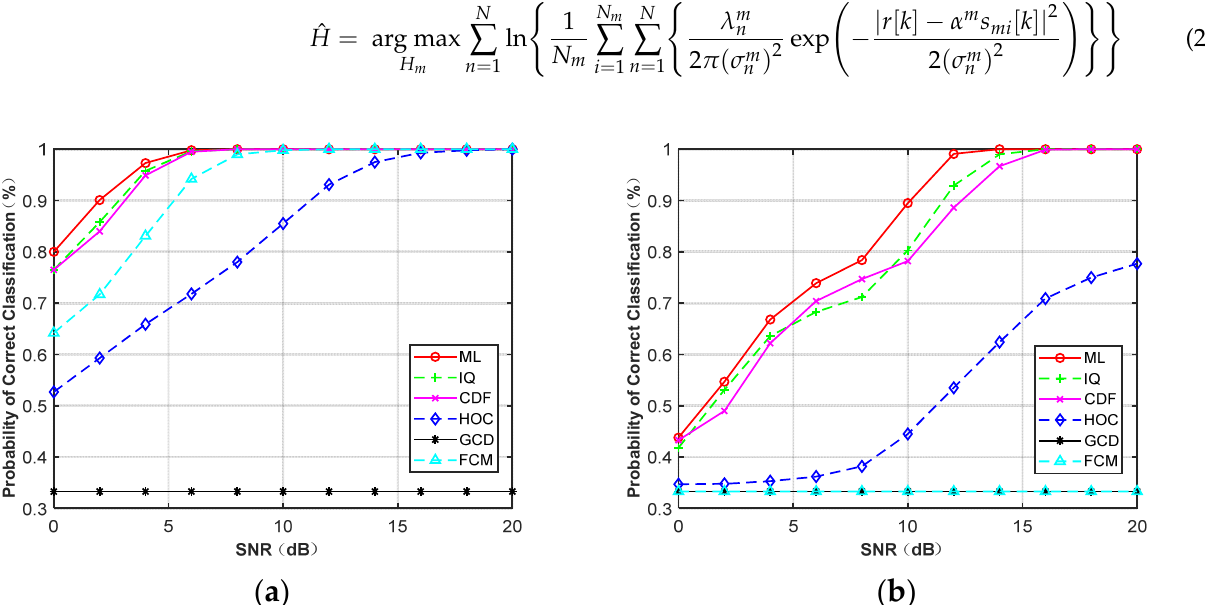
Figure 12. Probability of correct classification under non-Gaussian channel (N = 128). ( a ) MPSK. ( b ) MQAM.